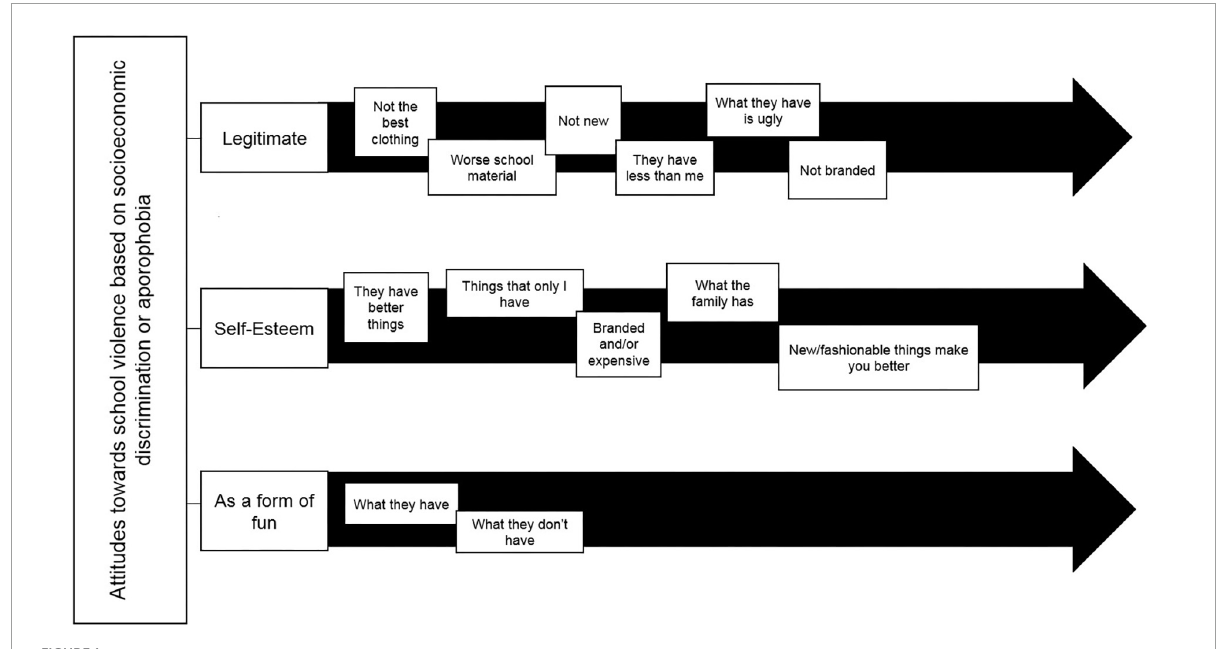
FIGURE1 Attitudes toward school violence based on socioeconomic discrimination or